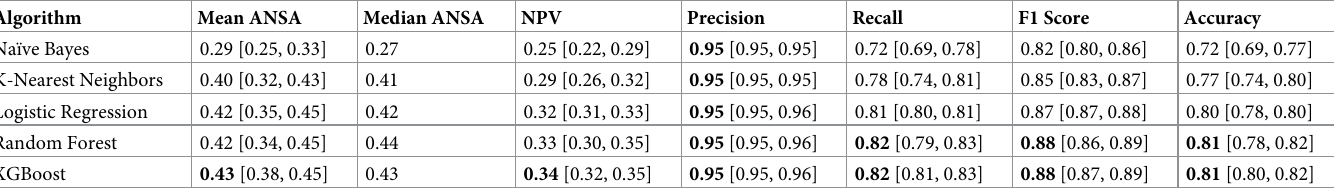
Table 2. Performance metrics.